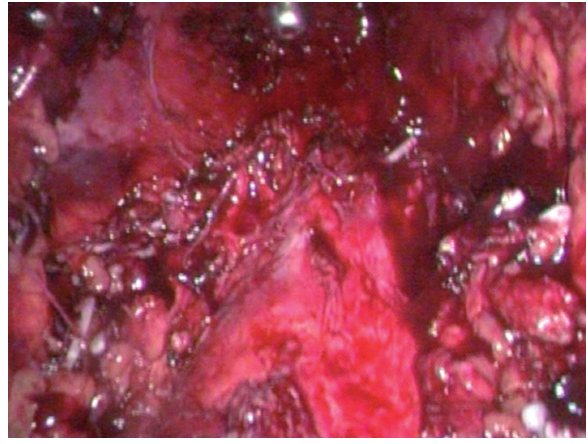
Figure 1 - Pelvic cavity after specimen removal.